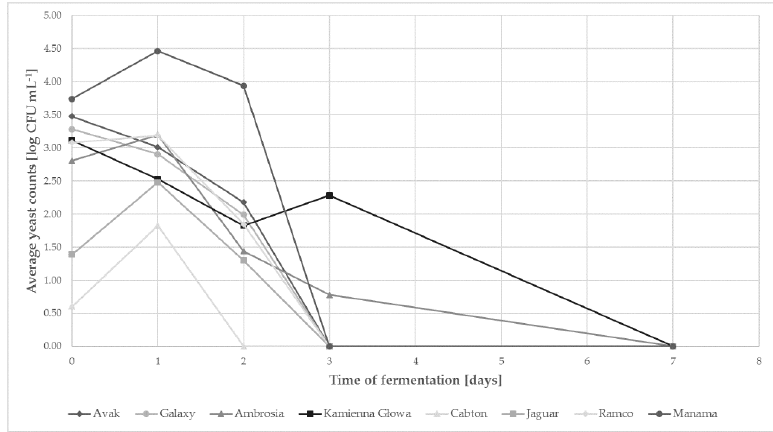
Figure 1. The amount of yeast cells during sauerkraut fermentation of different varieties (standard deviations do not exceed 5%).